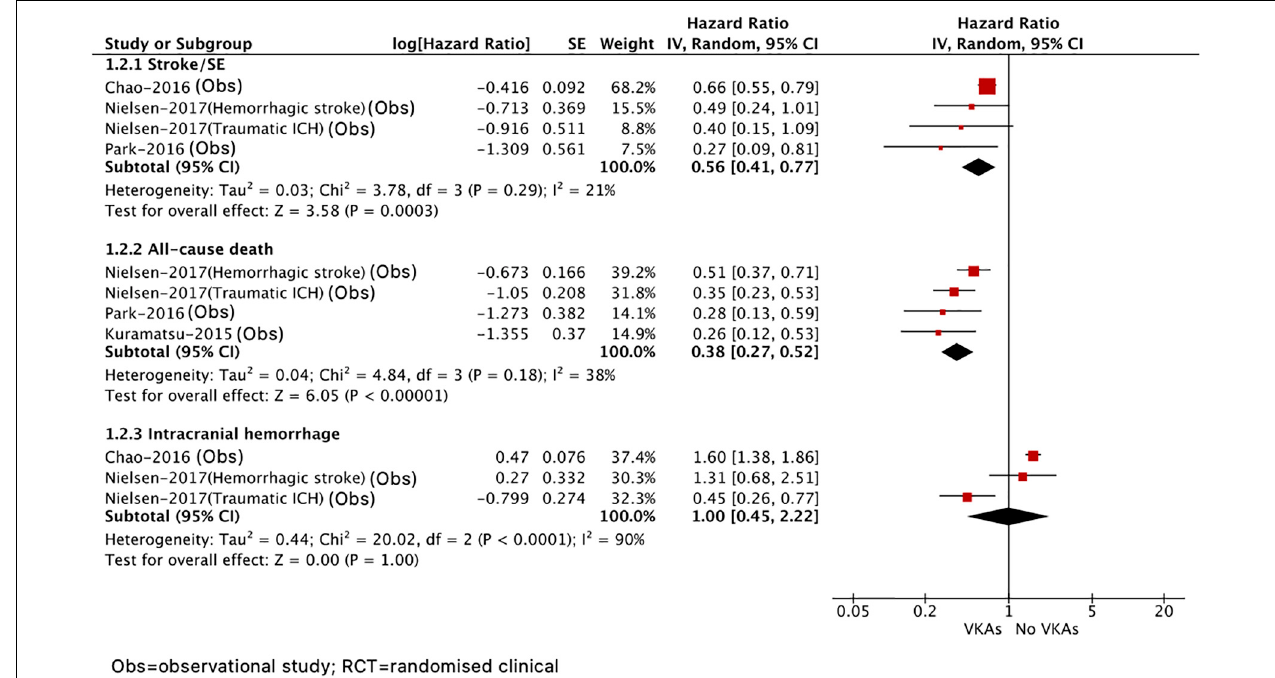
FIGURE 3 | Comparing the efficacy of VKAs with no VKAs in patients with AF after ICH. AF, atrial fibrillation; ICH, intracranial hemorrhage; VKAs, vitamin K anticoagulants; CI, confidence interval; IV, the inverse of the variance; and SE, standard